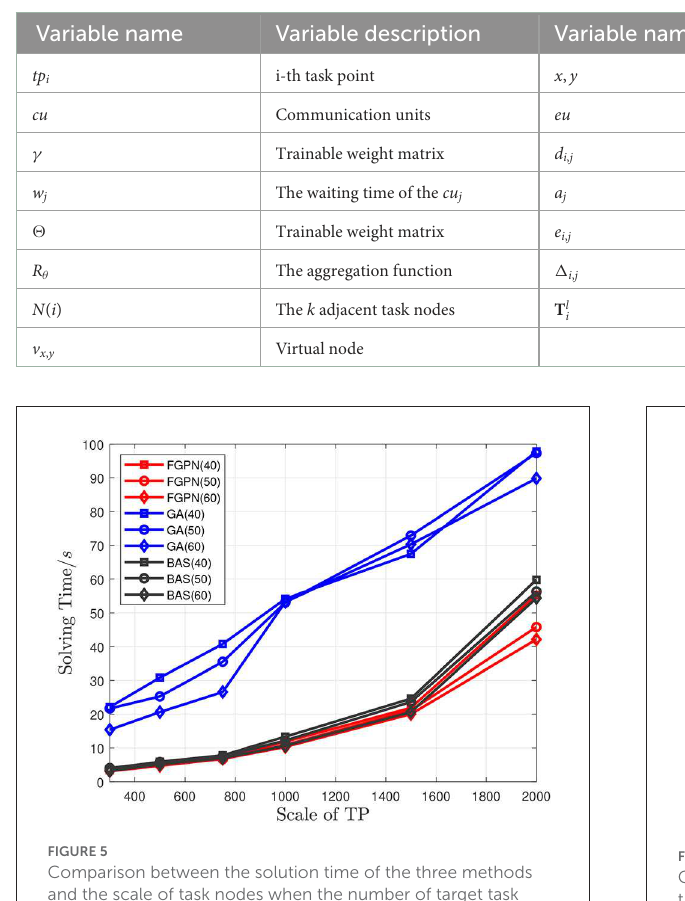
Experiment 1: Comparison of task allocation algorithms